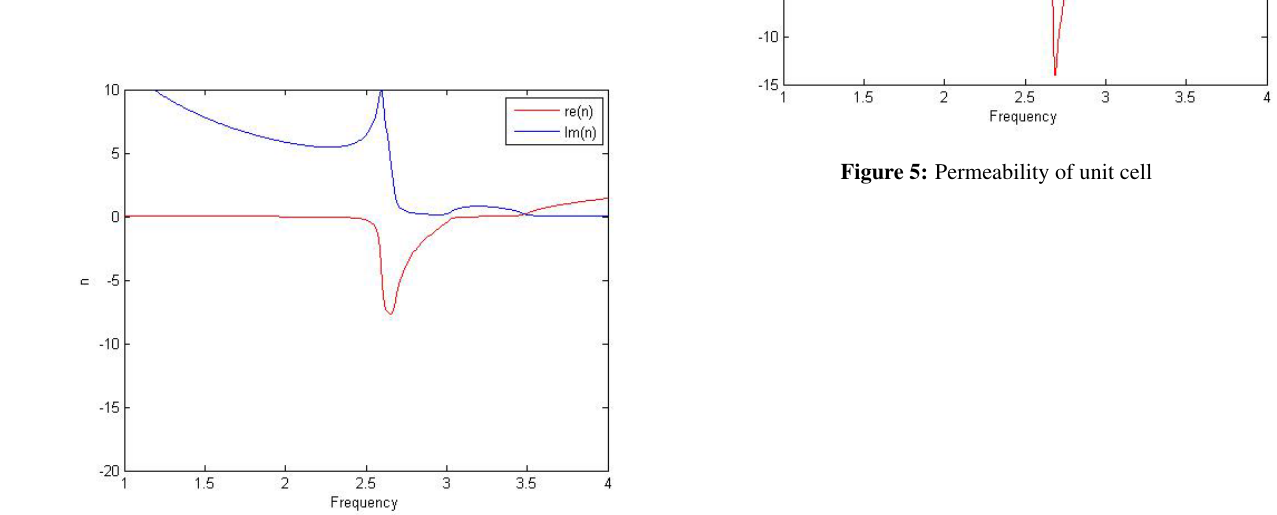
Figure 2: Impedance of unit cell